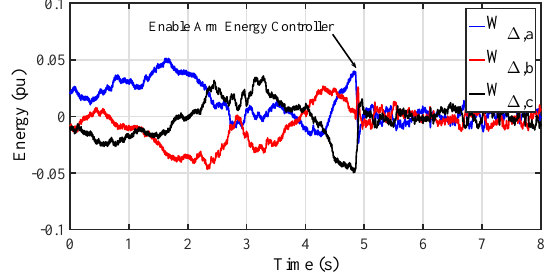
Figure 10. Arm energy controller experimental effect.